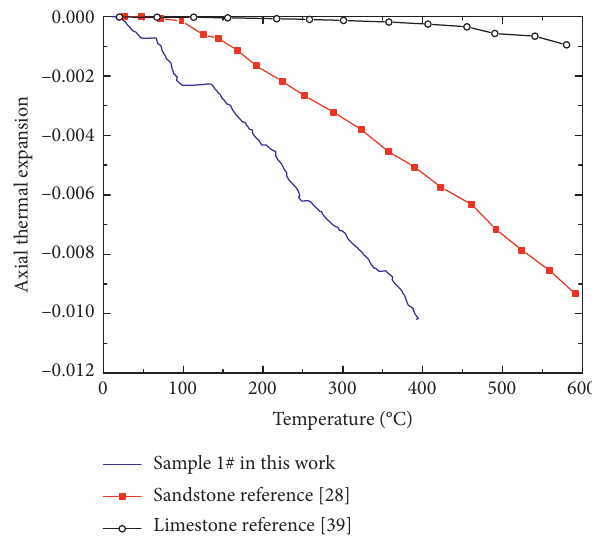
Figure 6: Comparison of axial thermal expansion for mudstone, sandstone, and limestone.